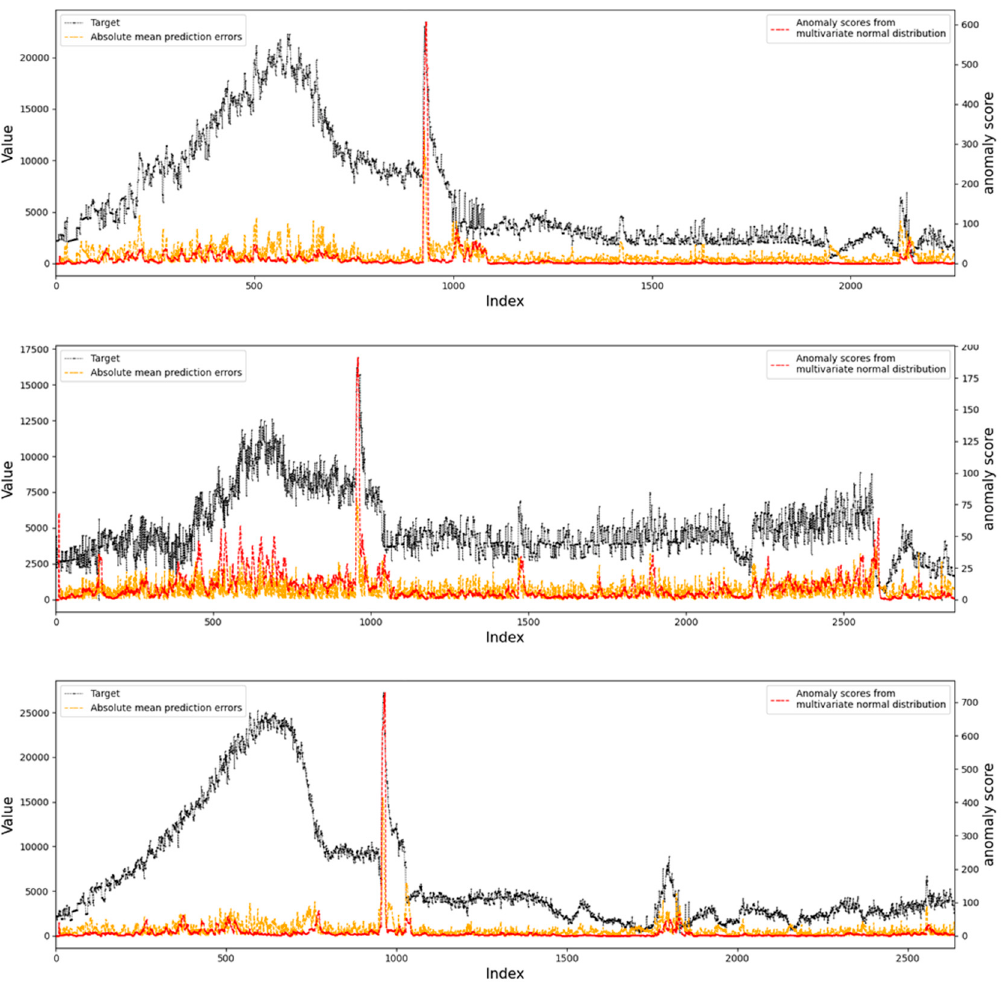
Figure 13. The anomaly detection renderings are on our datasets.